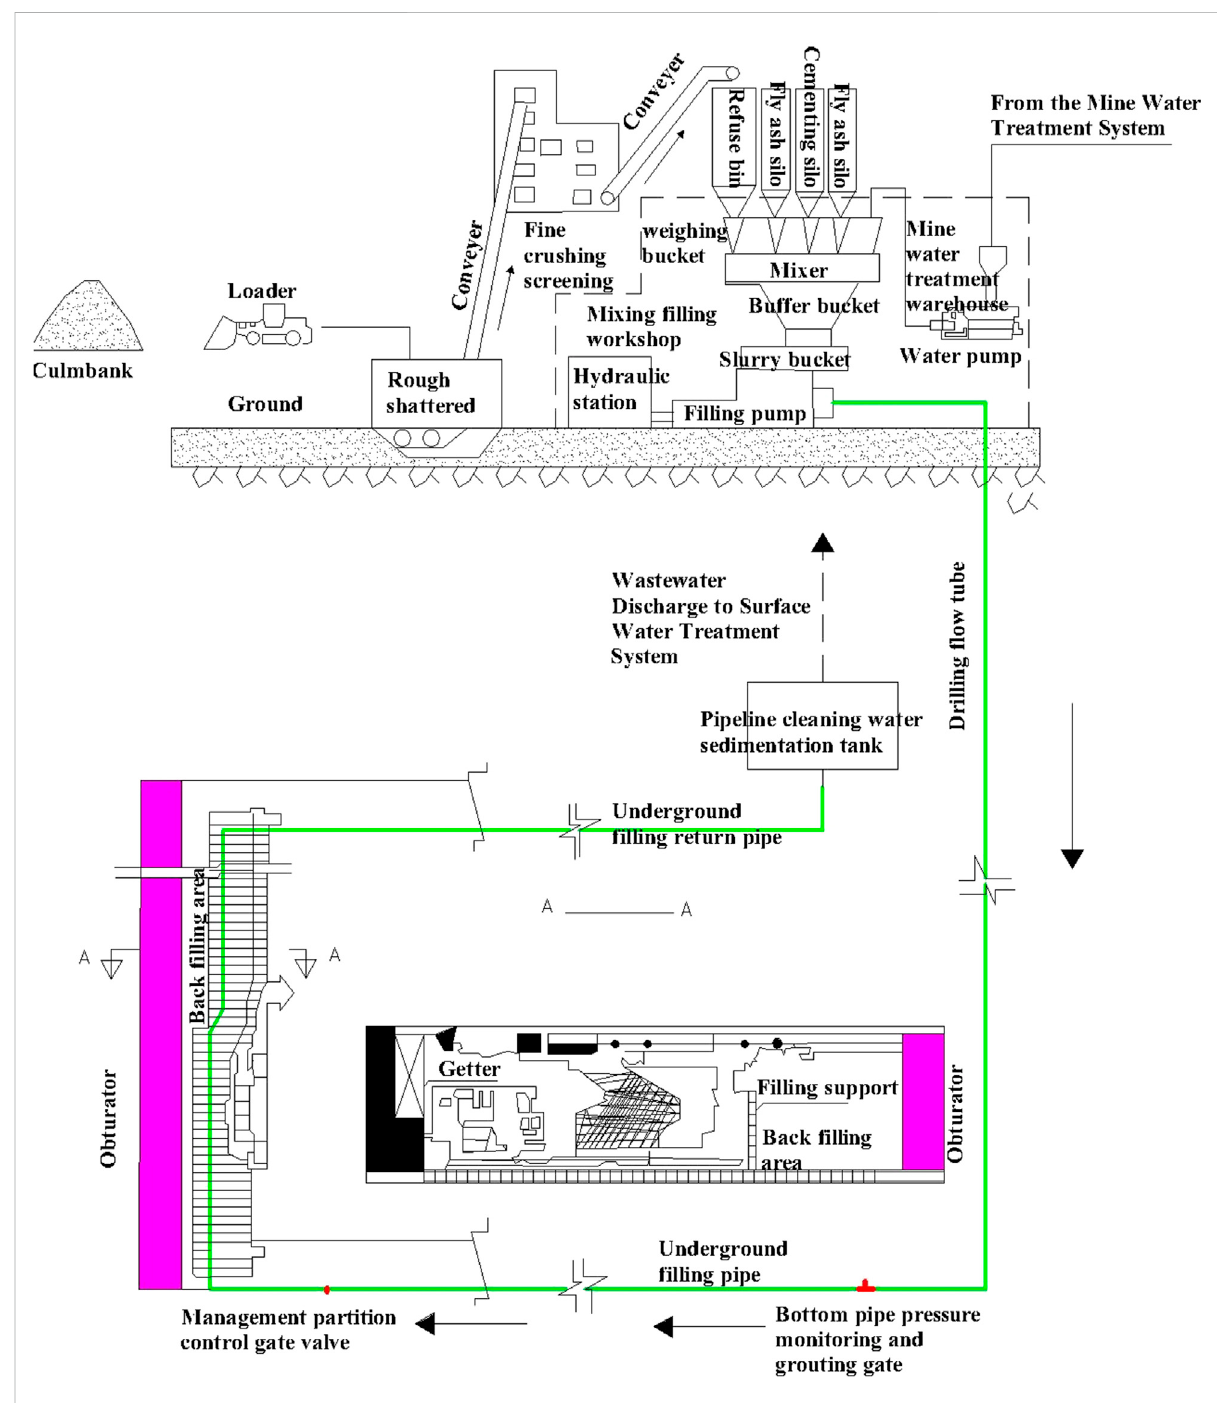
FIGURE 10 Process fl ow chart of the paste fi lling